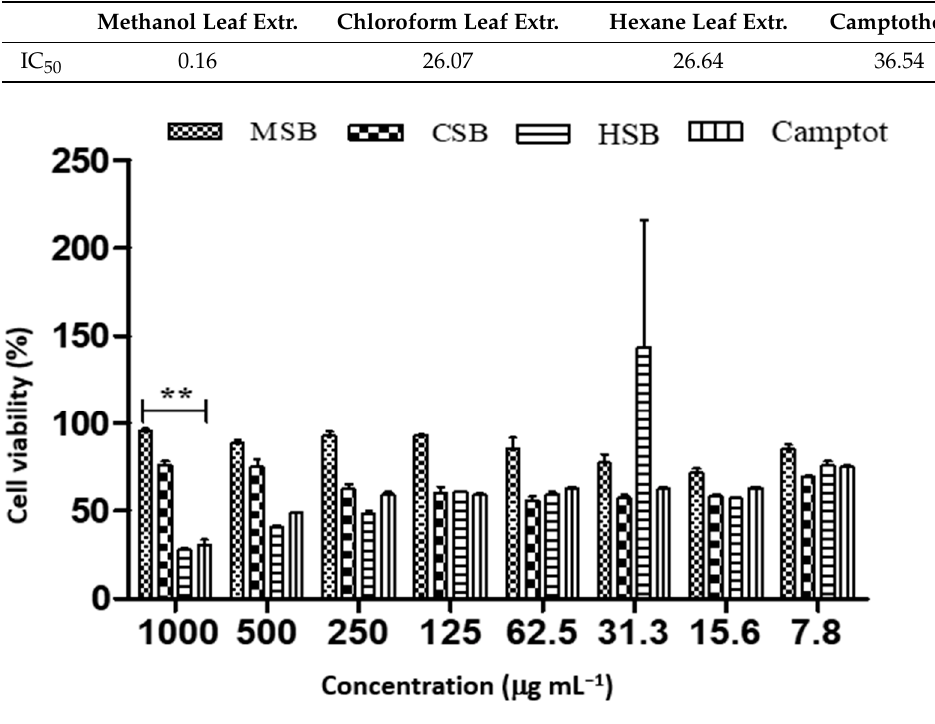
Figure 2. Cell viability of MCF-7 cancer cell lines treated with different concentrations of D. villosa stem extract. ** (Camptothecin vs. MSB), p < 0.01. Table 5. IC 50 values of D. villosa leaves and stem bark nanoparticles at both RT and 80 ◦ C against MCF-7